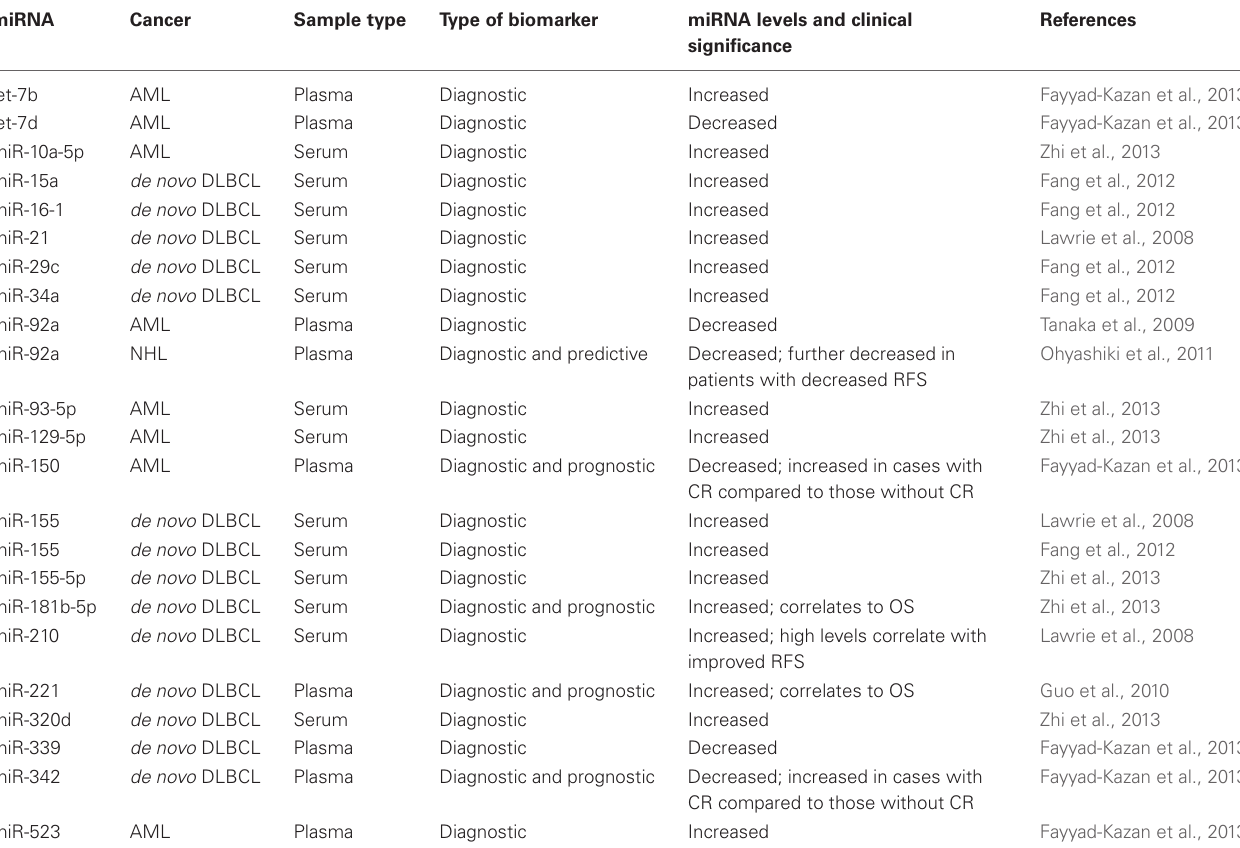
Table 6 | Circulating miRNAs reprted to be a biomarker for hematological